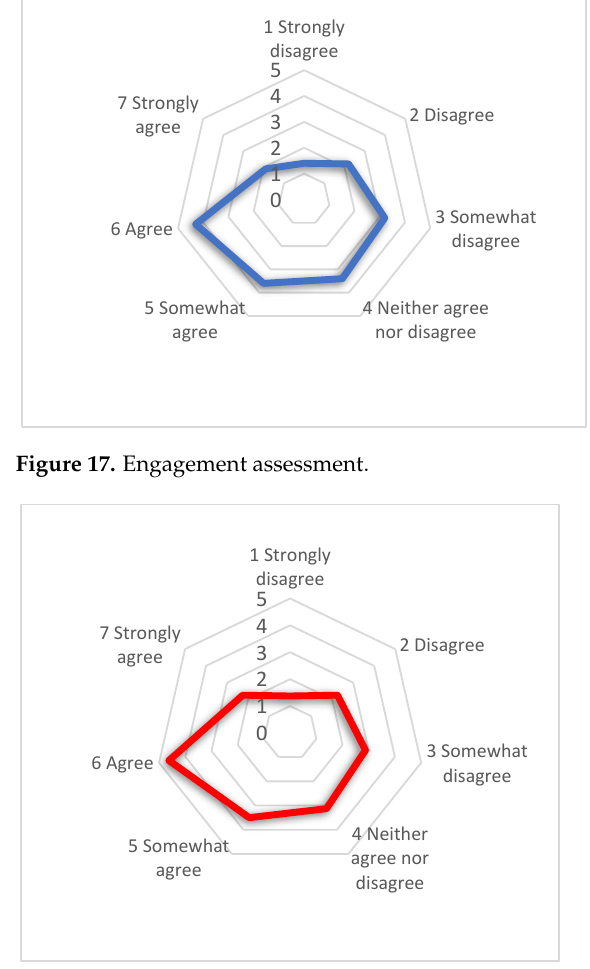
Figure 18. Manipulability assessment.